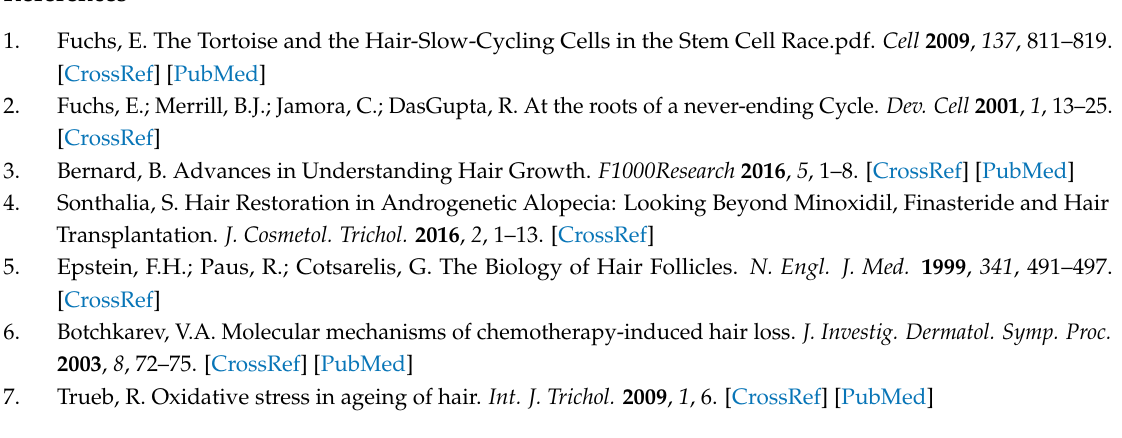
Figure S1: Partial least squares-discriminant analysis (PLS-DA) of HFs metabolites determined by FT-ICR–MS, Table S1: Identification of metabolites in HFs determined by